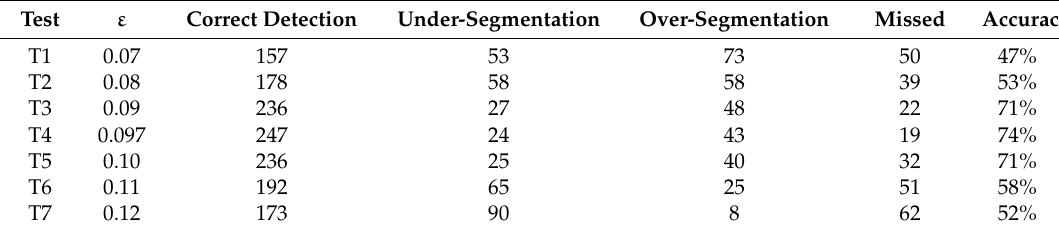
Table 4. Accuracy evaluation using different ε values for airborne laser scanning data using X , Y , Z , R , G , B